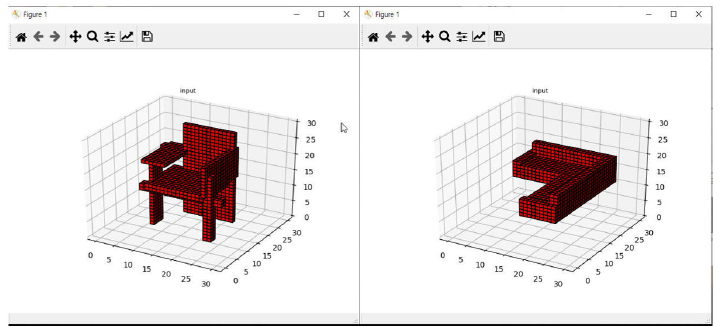
Figure 10. Voxelization of 3D geometry (30 × 30 ×